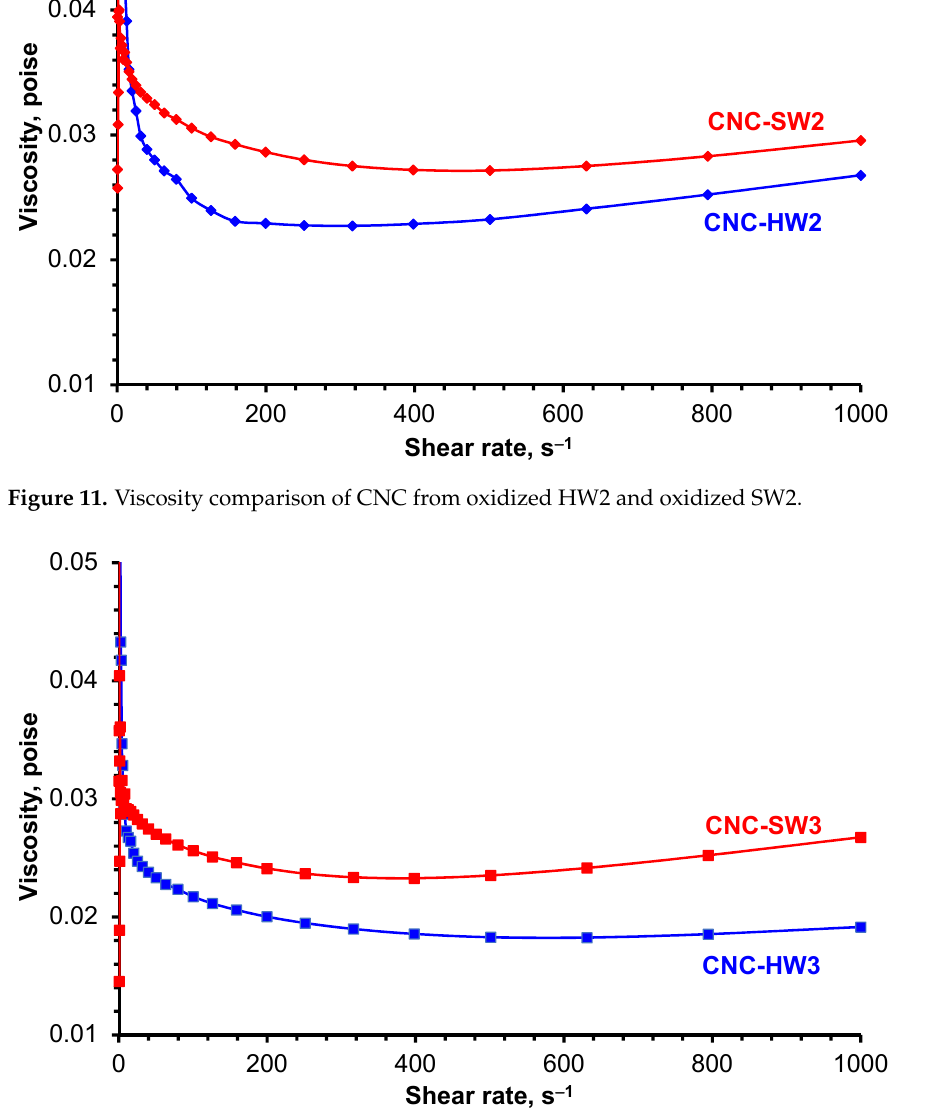
Figure 12. Viscosity comparison of CNC from oxidized HW3 and oxidized SW3.